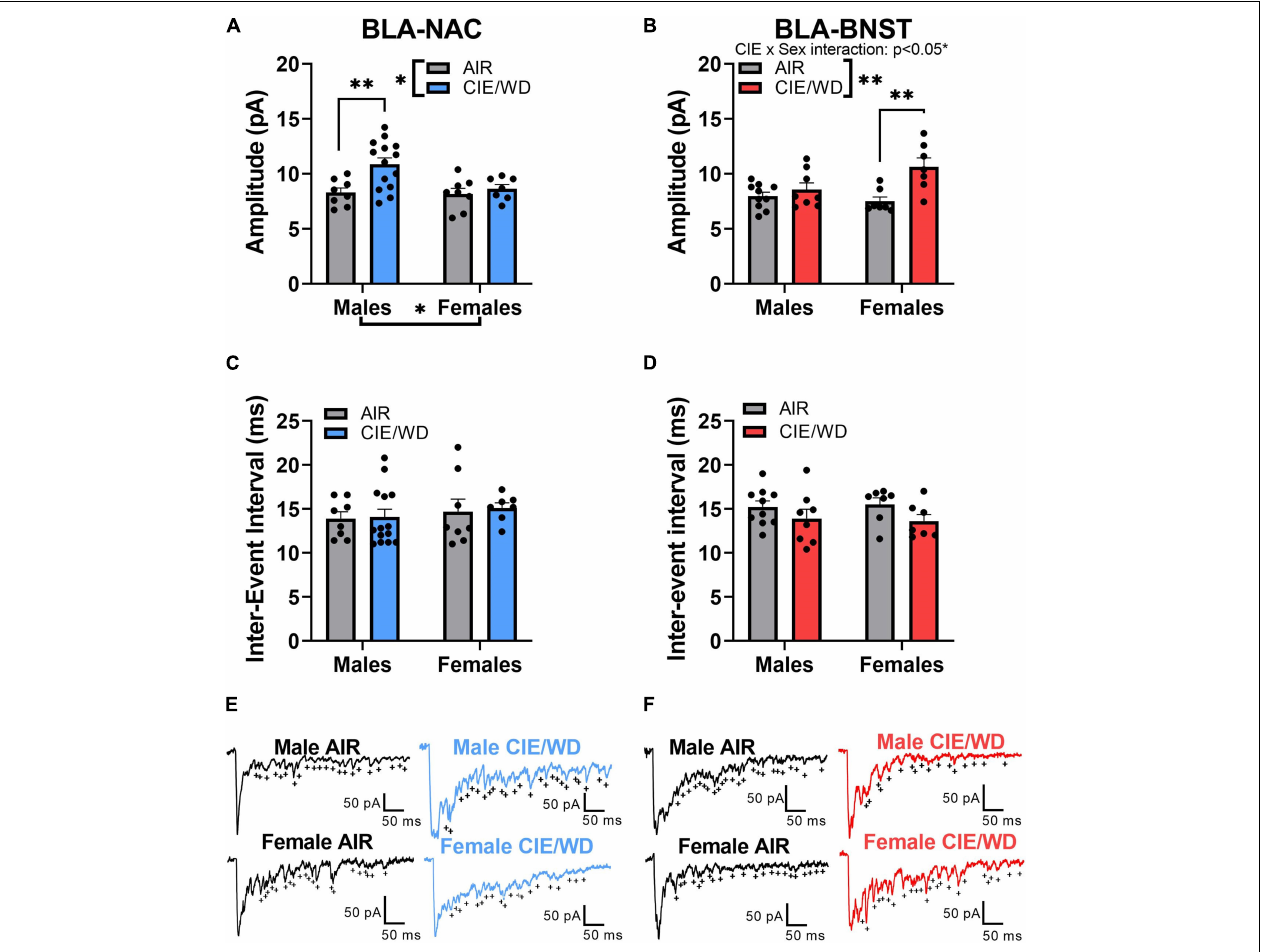
FIGURE 3 | CIE/WD increased postsynaptic glutamatergic function in external capsules synapses. (A) CIE/WD increased aEPSC amplitude in male BLA-NAC neurons (Males: n = 8 AIR, 14 CIE/WD; Females: n = 8 AIR, 7 CIE/WD). (B) CIE/WD increased aEPSC amplitude in female BLA-BNST neurons (Males: n = 10 AIR, 8 CIE/WD; Females: n = 7 AIR, 7 CIE/WD). (C) No effect of CIE/WD on aEPSC inter-event interval in BLA-NAC neurons. (D) No effect of CIE/WD on aEPSC inter-event interval in BLA-BNST neurons. (E) Exemplar traces of aEPSCs from BLA-NAC neurons in AIR males, CIE/WD males, AIR females, and CIE/WD females (+ indicate aEPSC events). (F) Exemplar traces of aEPSCs from BLA-BNST neurons in AIR males, CIE/WD males, AIR females, and CIE/WD females (+ indicate aEPSC events). Data analyzed by 2-way ANOVAs. ∗∗ p < 0.01, ∗ p <